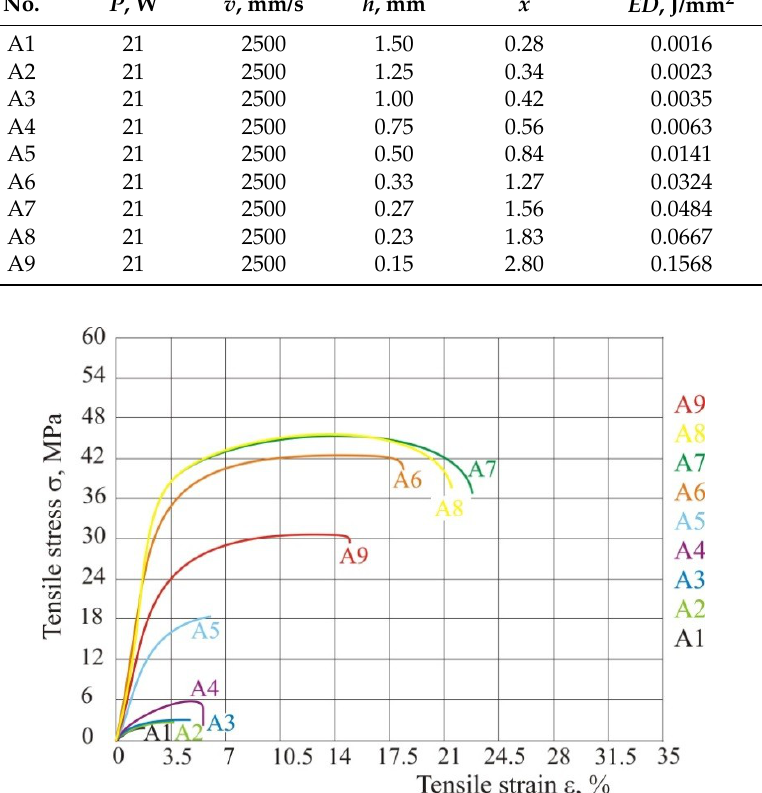
Figure 11. Tensile stress–strain curve with different beam overlay ratio according to Table 7.